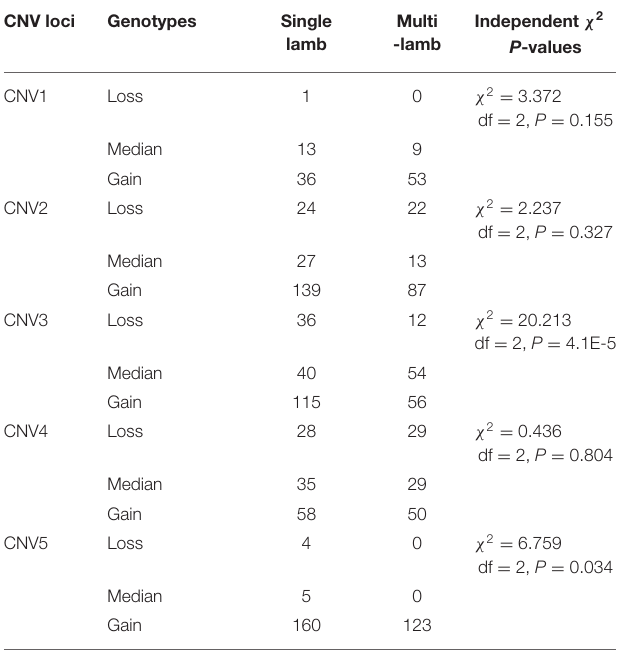
TABLE 7 | Type distribution between mothers of single lamb and multi-lamb in Shaanbei white cashmere